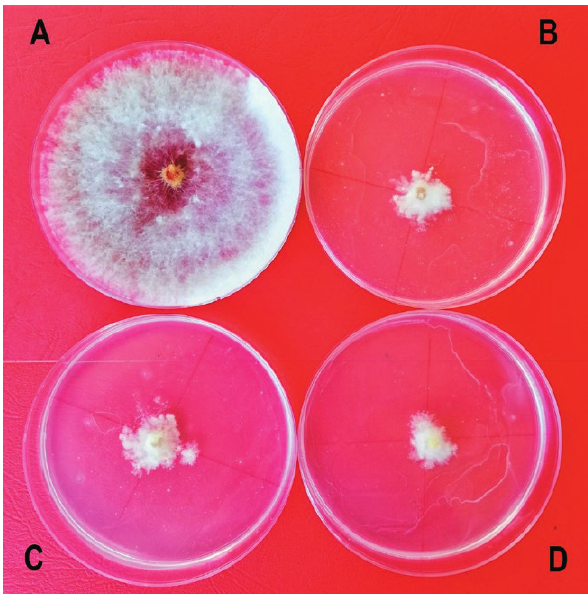
Figure 1. Colonies of Fusarium culmorum after 216 h incubation with different bacterial strains applied at 1 × 10 6 CFU mL -1 in agar medium. The plates were each centrally seeded with a 5 mm diam. plug of F. culmorum . Letters represent: A, F . culmorum alone; B, the pathogen with isolate G1 ( Pan . agglomerans ); C, with isolate F15 ( Pan . agglomerans ); D, with isolate B ( Pae . polymyxa ).